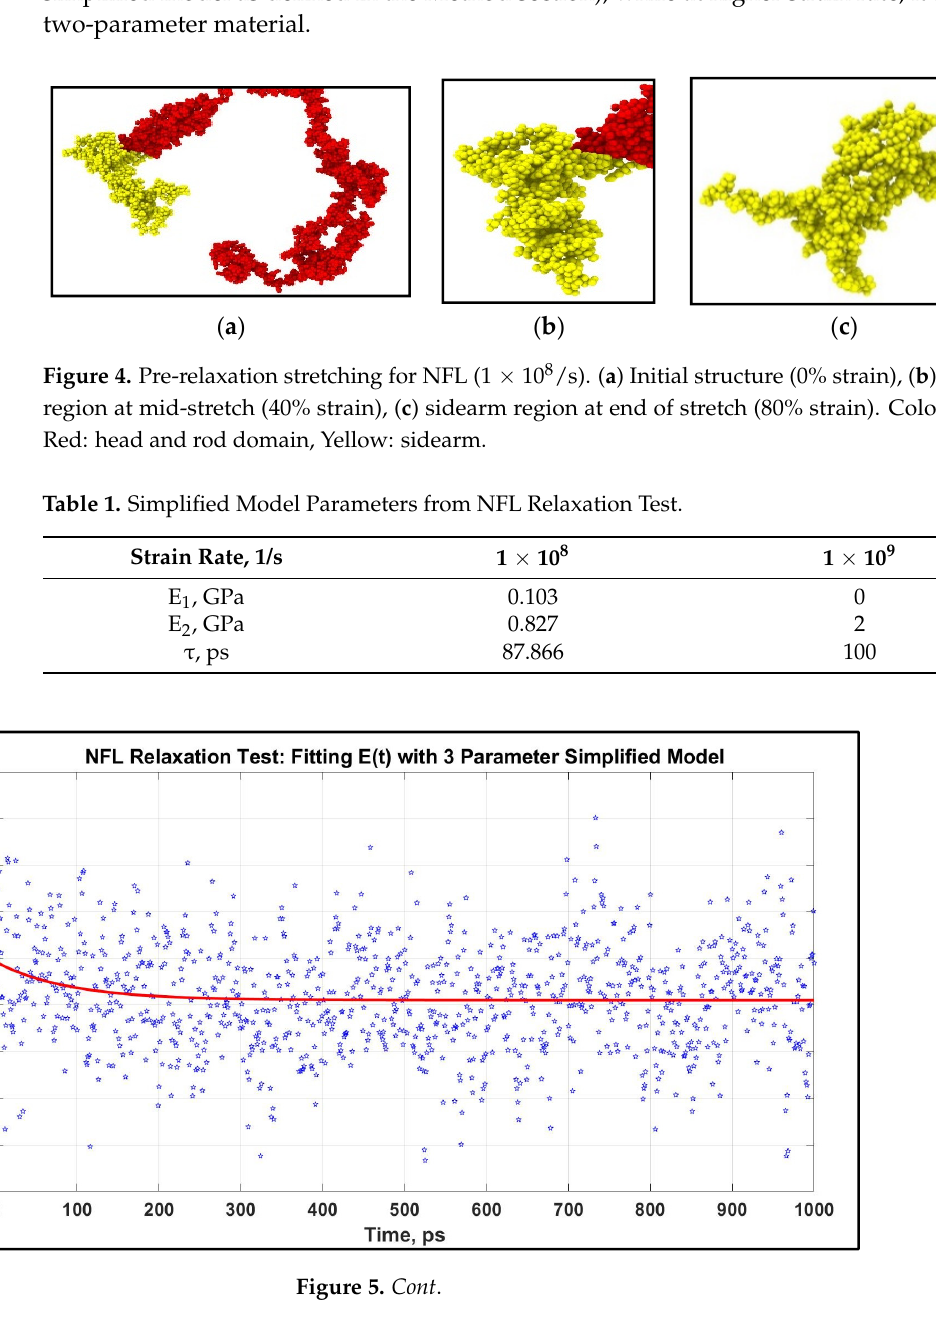
9 of 18 Figure 3. Snapshots at different timesteps during the tensile test performed on NFL and NFH (strain rate: 1 × 10 9 s − 1 ). ( a ) Initial structure of NFL; ( b ) NFL tail region: 0% strain; ( c ) NFL tail region: 180% strain, showing simultaneous unfolding and stretching; ( d ) NFL tail region: 360% strain, showing pure stretching at significant portion of tail region; ( e ) Initial structure of NFH; ( f ) NFH tail region: 0% strain; ( g ) NFH tail region: 160% strain, showing simultaneous unfolding and stretching; ( h ) NFH tail region: 320% strain, showing pure stretching at significant portion of tail region. Color legend: Red: head domain, blue: rod domain, yellow: tail region. 3.2. Viscoelastic Modeling of Neurofilaments We have performed a relaxation test on NFL. As NF sidearms dictate the sidearm spacing and eventually the axon diameter by orienting themselves as parallel filaments to